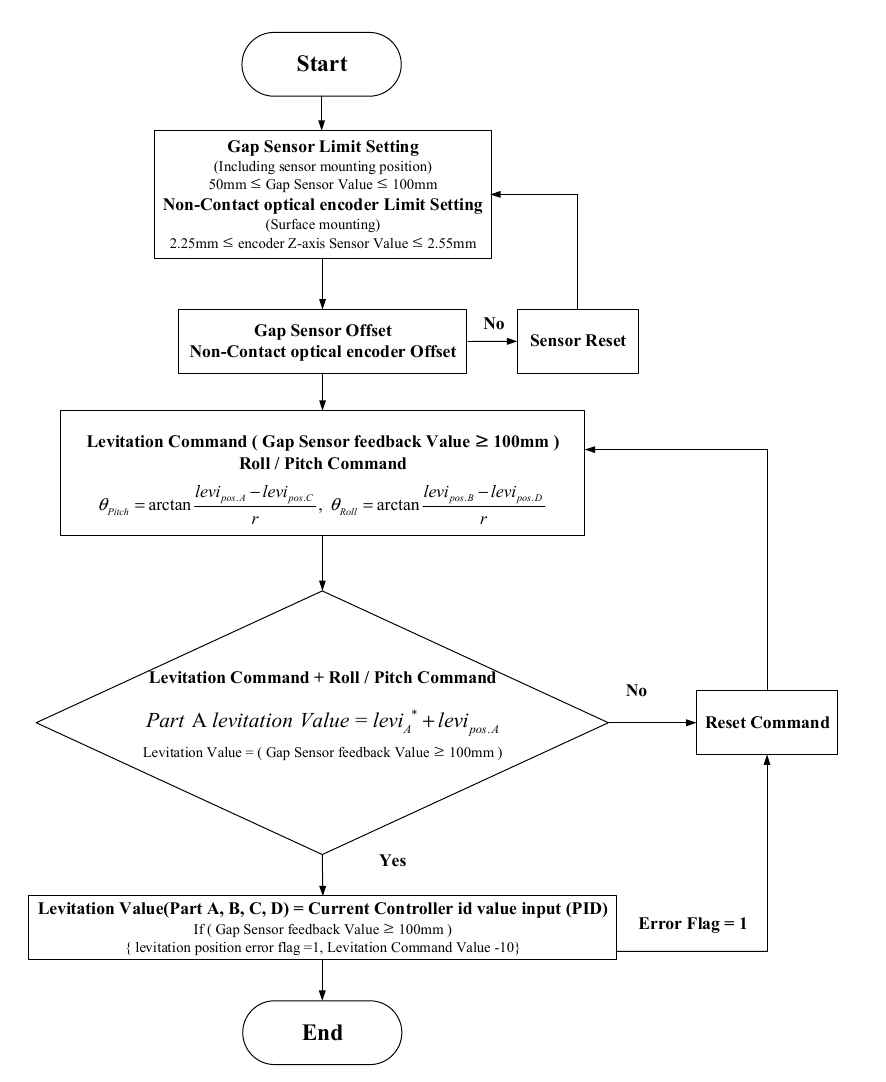
Figure 7. Control limit setting using Z-axis sensing range of non-contact encoder and Gap Sensor.